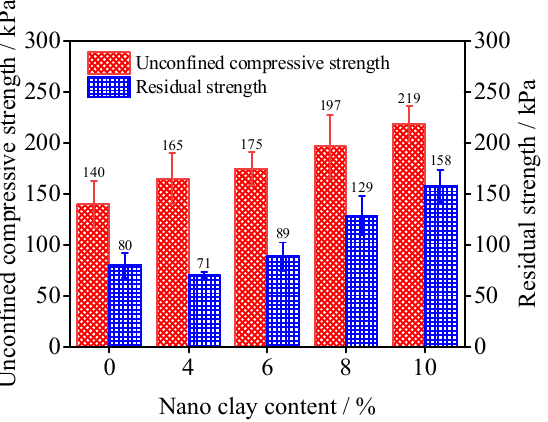
Figure 3. Unconfined compressive strength and residual strength diagram of SCSC sample. When nano-clay content increases, residual strength changes. The residual strengths of SCSC6, SCSC8 and SCSC10 are 89 kPa, 129 kPa and 158 kPa, respectively, which is 11%, 61% and 98% higher than that of SCSC0. However, the residual strength of SCSC4 is 13% lower than that of SCSC0, which indicates that the residual strength of the samples was only improved by the incorporation of nano-clay at 6% or more.